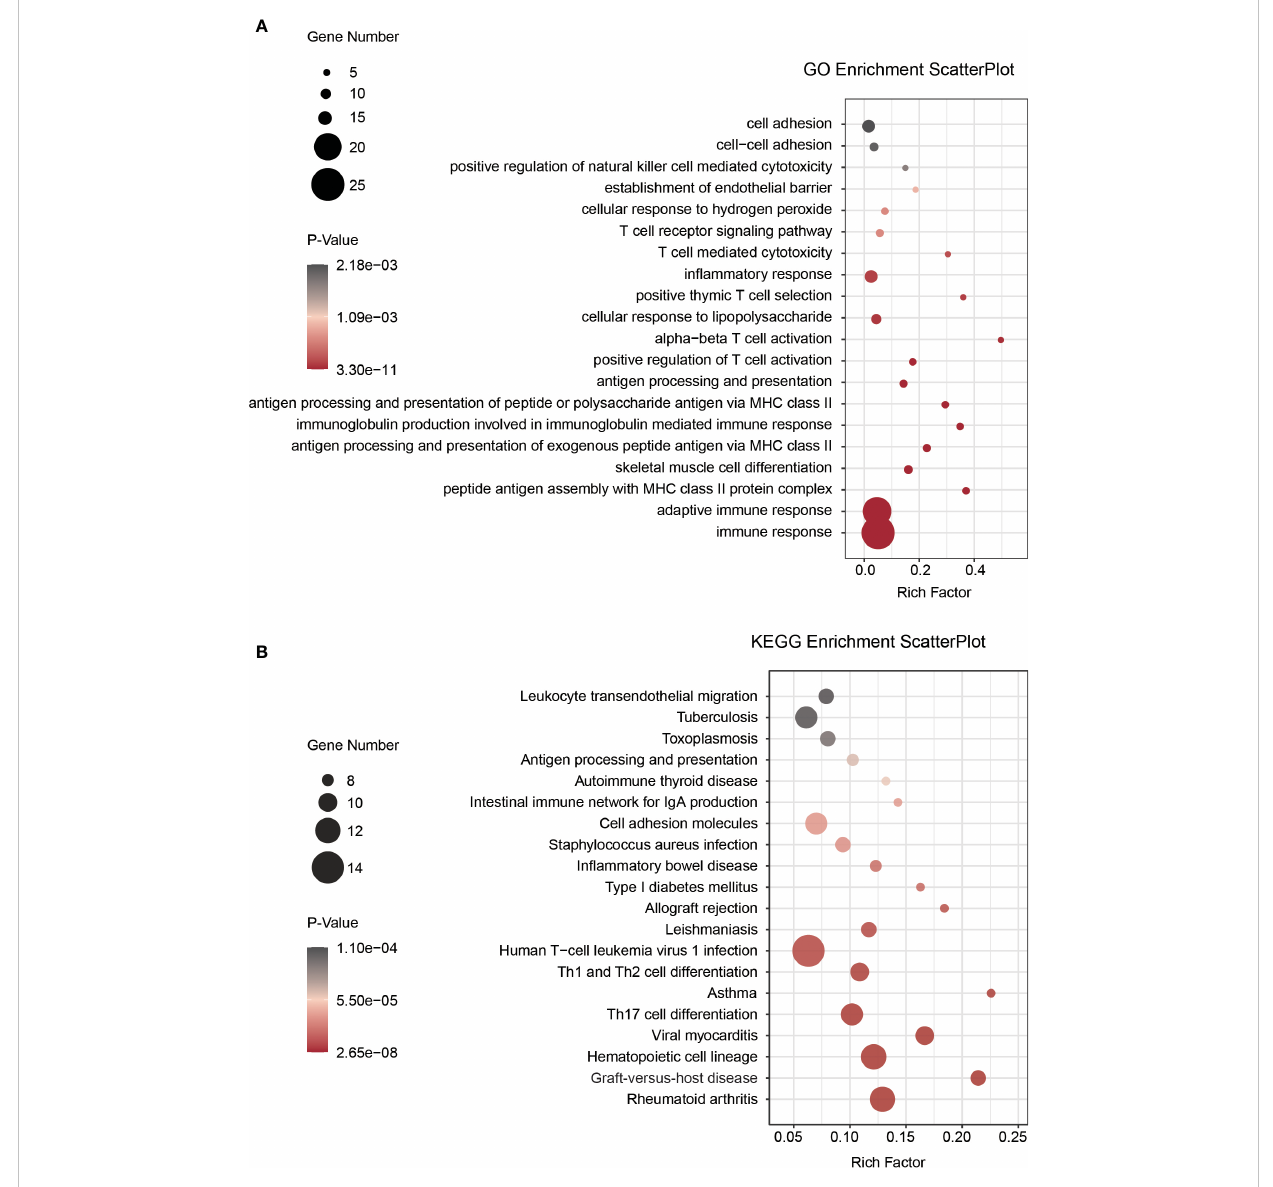
FIGURE 7 The enrichment analysis between the low SOCS3 expression group and the high SOCS3 group in the exceptional DEGs in lung metastasis. (A) Biological process. (B) KEGG